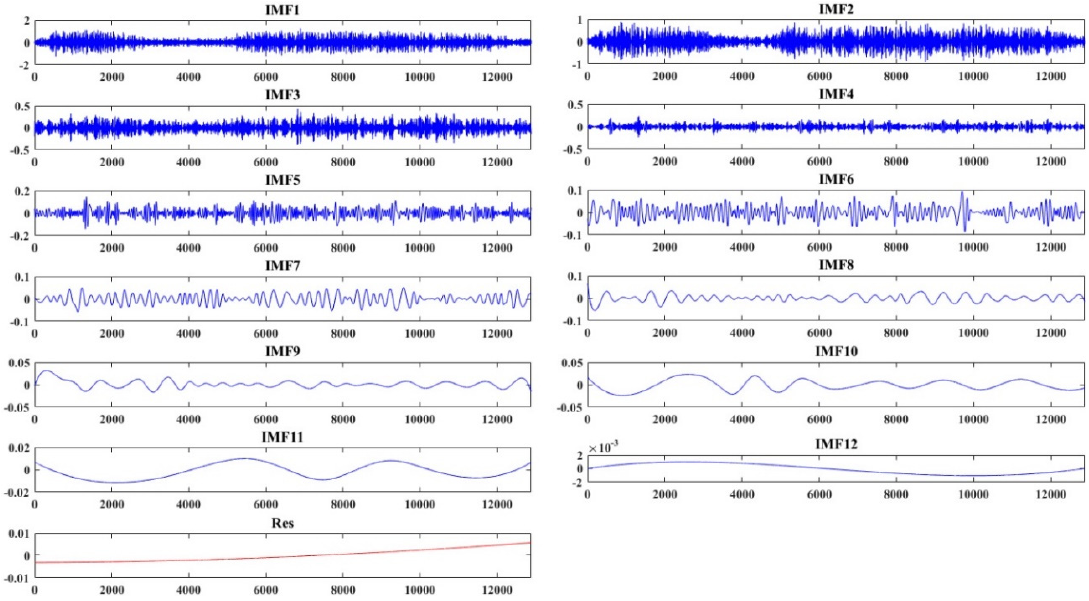
Figure 6. Empirical mode decomposition (EMD) result of the noisy signal. IMF: intrinsic mode function. (3) EMD-PSO denoising. The noisy signal was first decomposed by EMD adaptively. Then, the threshold of each IMF was determined according to PSO intelligently. Soft threshold function was applied and the denoised signal was reconstructed as Equation (9). Some parameters during the EMD-PSO were set as recommended in [23]: M 1 = 2, M 2 = 4, the dimensionality of each particle was M 2 − M 1 + 1 = 3, the learning factor c 1 and c 2 were set as 2, the iteration number was 100 and the particle number of the population was 10. (4) EMD-FOA denoising. The noisy signal was first decomposed by EMD adaptively. Then, the threshold of each IMF was determined according to FOA automatically. Soft threshold function was applied and the denoised signal was reconstructed as Equation (9). Some parameters during the EMD-FOA were set as follows: M 1 = 2, M 2 = 4, the number of fruit fly population was M 2 − M 1 + 1 = 3, the iteration number was 100, the fly number in each population was 10, the fruit fly location range and the random fly distance range was 1. (5) EMD-IFOA denoising. The noisy signal was first decomposed by EMD adaptively. Then, the threshold of each IMF was determined according to IFOA automatically. Soft threshold function was applied and the denoised signal was reconstructed as Equation (9). Some parameters during the EMD-IFOA were set as follows: M 1 = 2, M 2 = 4, the number of fruit fly population was M 2 − M 1 + 1 = 3, the iteration number was 100, the fly number in each population was 10, the fruit fly location range and the random fly distance range was 1, the variation coefficient C v = 0.2 and disturbance coefficient C d = 5. The denoised signal of the five noise elimination schemes are presented in Figure